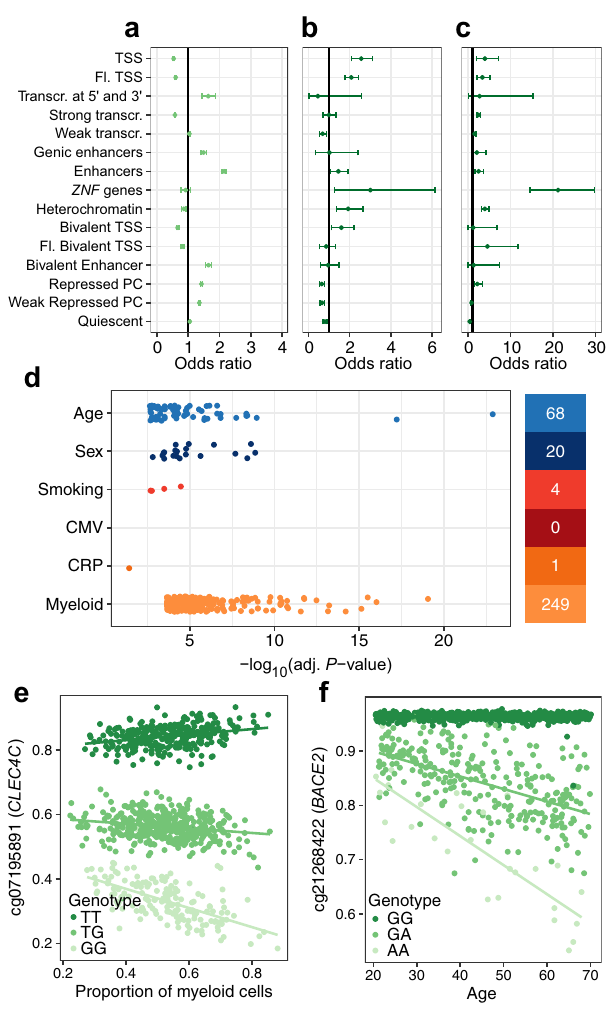
Fig. 4 | Effects of genetics and gene×environment interactions on the blood DNAmethylome.a EnrichmentinCpGsitesassociatedwithlocalmeQTLvariants, across 15 chromatin states. b Enrichment in CpG sites associated with remote meQTL variants, across 15 chromatin states. c Enrichment in remote meQTL var- iants, across 15 chromatin states. d P -value distributions for signi fi cant effects of genotype×age, genotype×sex, genotype×smoking, genotype×CMV serostatus, genotype×CRP levels and genotype×cell-type interactions. The number of sig- ni fi cant associations is indicated on the right. Associations were tested by two- sided Wald tests with heteroscedasticity-consistent standard errors estimated by the sandwich R package 117 . Multiple testing was done by the Bonferroni correction separately for each term. e Myeloid lineage-dependent effect of the rs11055602 varianton5mClevelsatthe CLEC4C locus. f Age-dependenteffectofthers2837990 variant on 5mC levels atthe BACE2 locus. a – c The point and error bars indicate the odds-ratioand95%CI.CIswereestimatedbytheFisher ’ sexactmethod.Chromatin states were de fi ned in PBMCs 15 . TSS, Fl. and PC denote transcription start site, fl anking and Polycomb, respectively. e , f 5mC levels are given in the β value scale. Solid lines indicate linear regression lines. Statistics were computed based on a sample size of n =884 and for 644,517 CpG